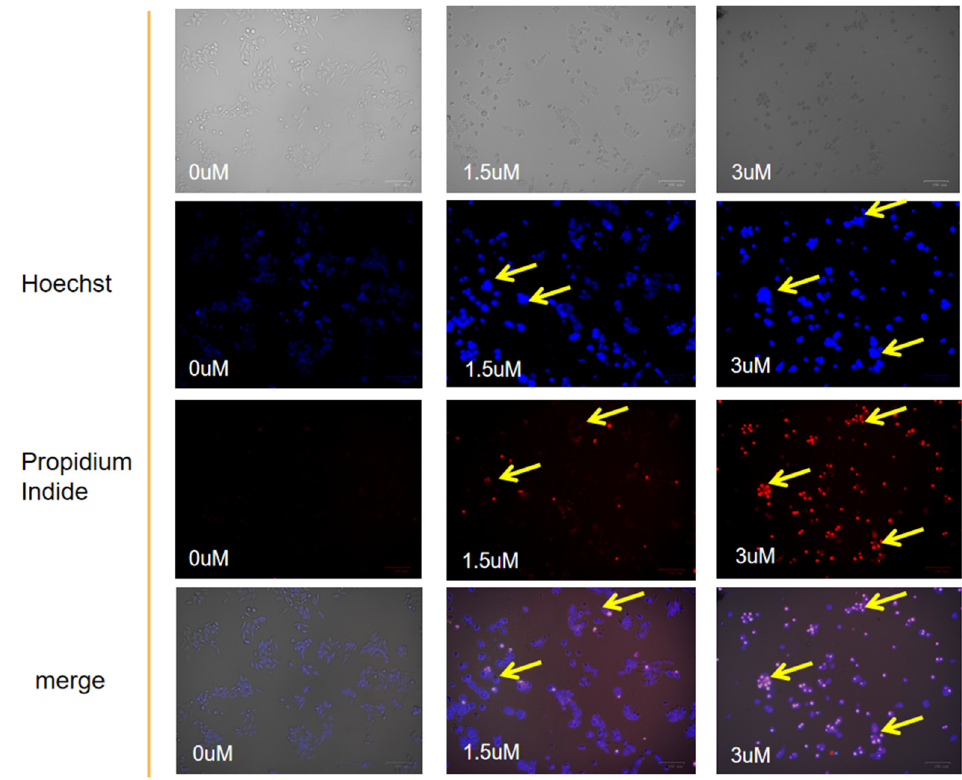
Figure 5. Hoechst 33342 and PI staining to observe the effect of DTB on the apoptotic morphology of human colon cancer LOVO cells. The bright blue and red coloring can be seen at the place indicated by the yellow arrow.